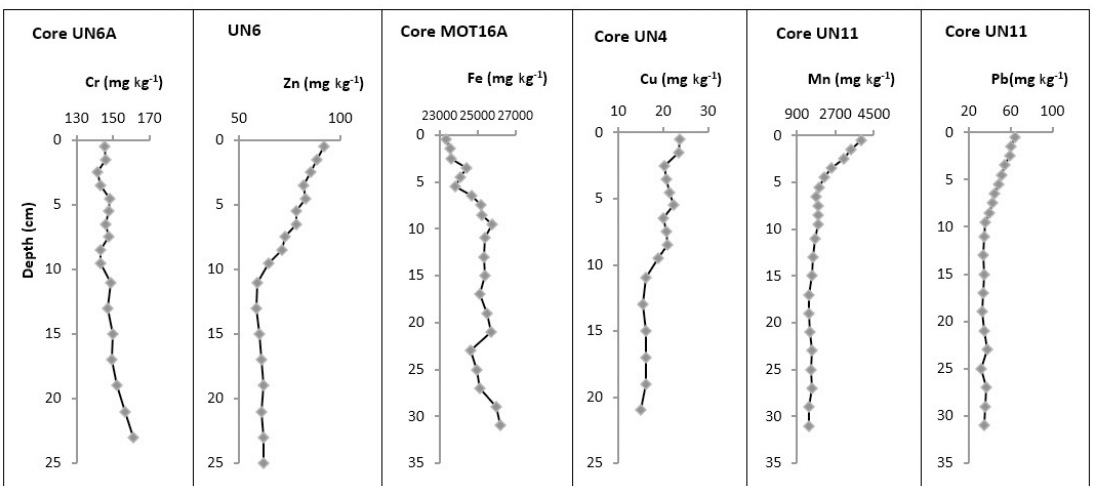
Figure 3. Vertical profiles of Cr, Fe, Cu and Zn at the muddy sediments of cores UN6A, MOT16A, UN4 and UN6, respectively, and Mn and Pb along core UN11.